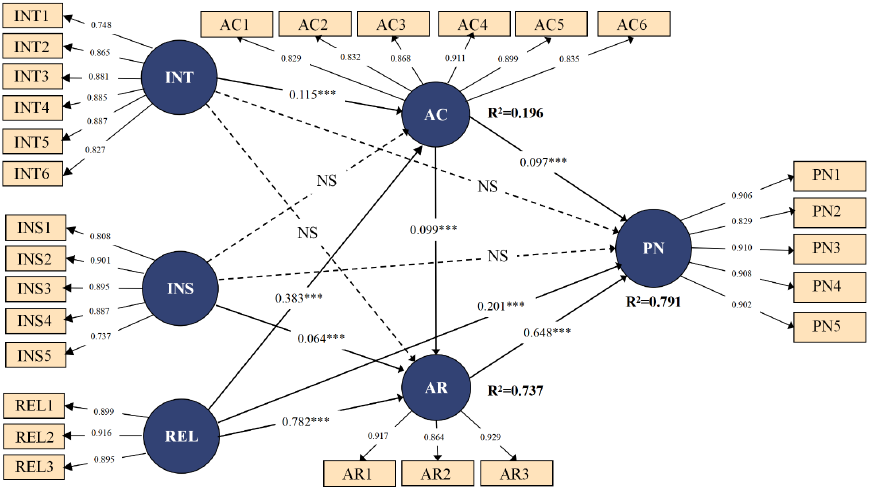
Figure 3. Partial Least Square Structural Modeling (PLS-SEM) model simulation results. (Note: * p < 0.05, ** p < 0.01, and *** p < 0.001.) via Bootstrapping (Subsamples = 2000). Based on the results (Table 7), all three UGSVOs had an indirect significant positive effect on personal norms through awareness of conse- quences and ascription of responsibility as mediators. The relational UGSVO had the strongest total effects on awareness of consequences, ascription of responsibility, and per- sonal norms. Among all of the paths (total effects), only the effect of the instrumental UGSVO on awareness of consequences was not significant.